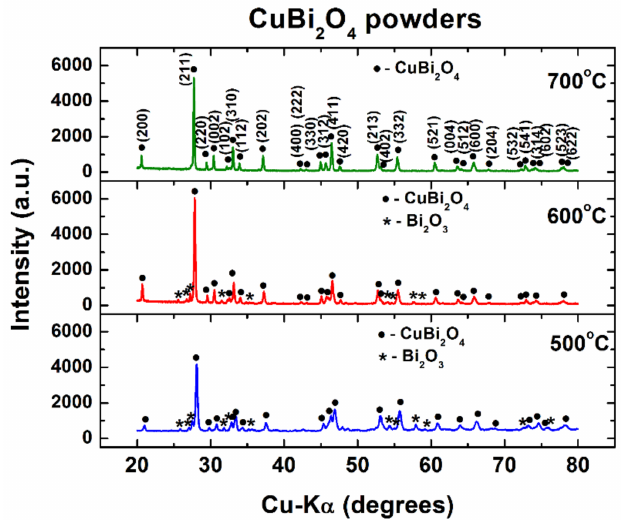
Figure 3. X-ray diffraction (XRD) patterns at room temperature for the CuBi 2 O 4 powders calcined at various